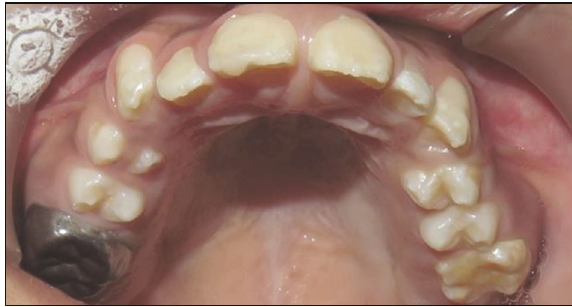
Figure 7: Intraoral upper